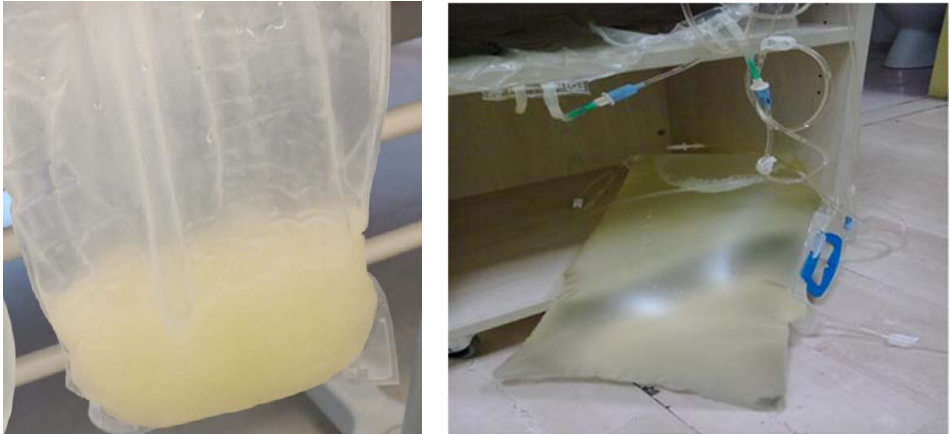
Figure 1. Appearance of peritoneal effluent before ( left panel ) and the day after ( right panel ) the suspension of manidipine. The same variation from cloudy peritoneal fluid with a milky appearance to a normal clear appearance was observed in the other patients of the present report upon withdrawal of the calcium channel blocker